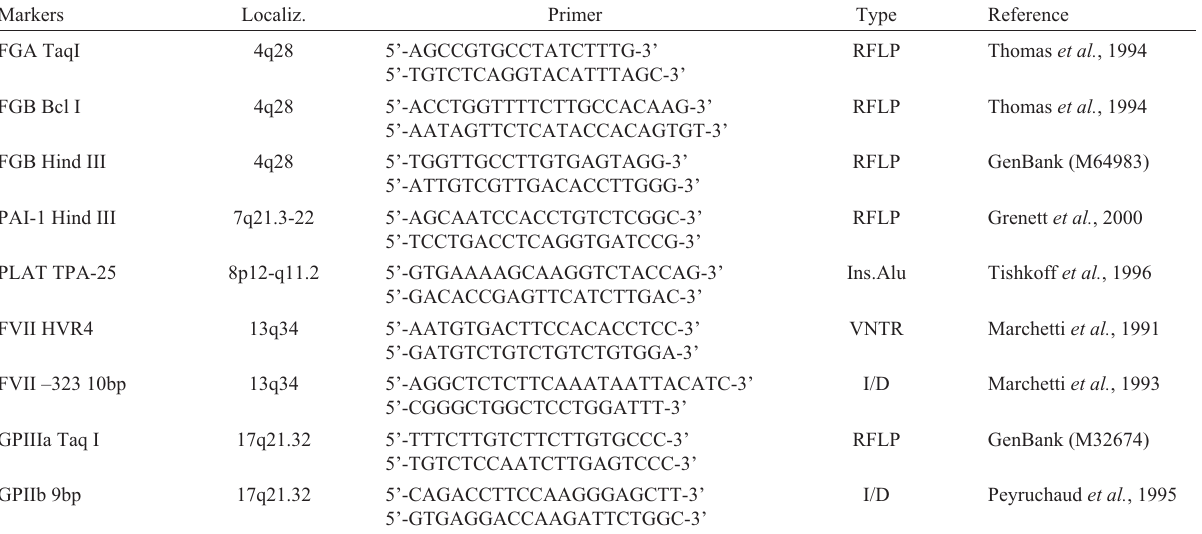
Table 1 - Chromosomal localizations, oligonucleotides and type of the studied genetic markers. Markers Localiz.